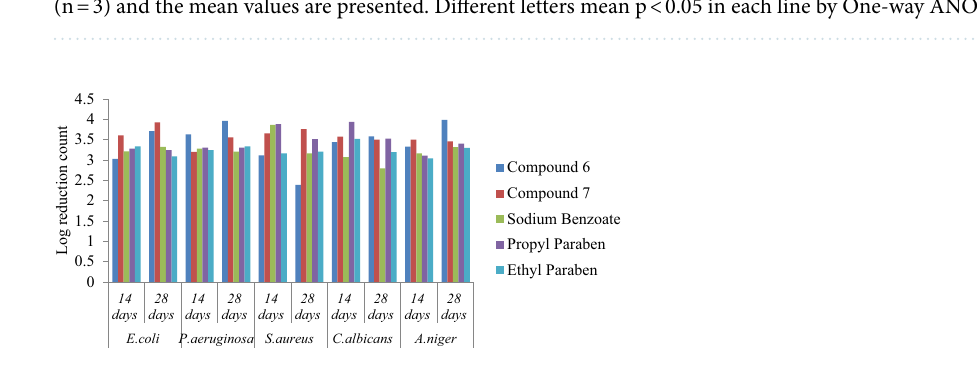
Figure 1. Preservative efficacy of compound 7 in White lotion USP and the degree of microbial log reduction.